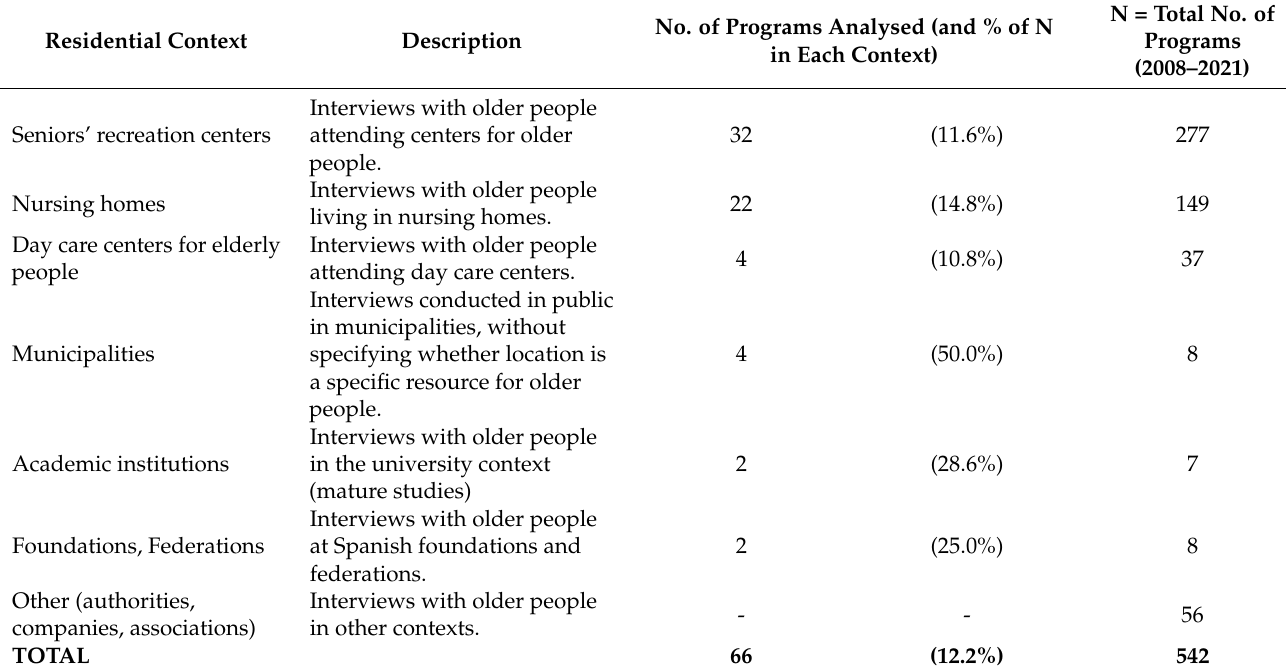
Table 2. Distribution of interviews in “wise words” segment by residential